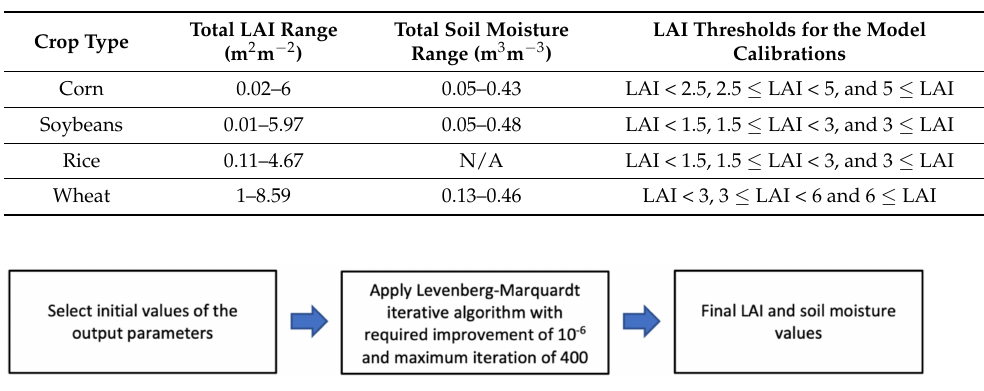
Table 3. Ranges of LAI and soil moisture from all JECAM sites.